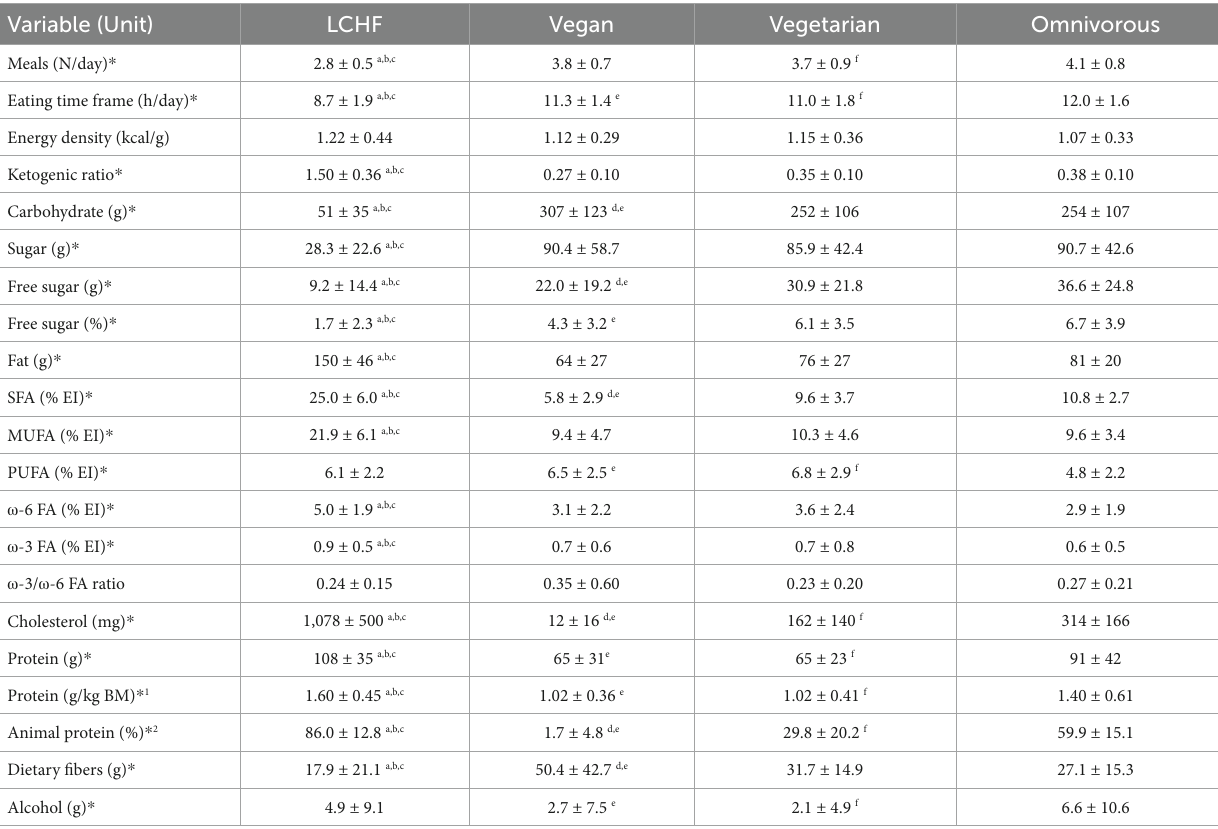
TABLE 3 Energy and macronutrient